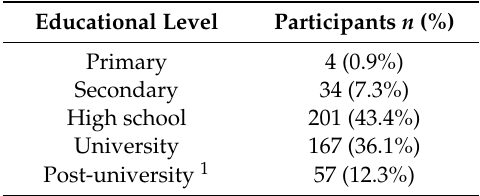
Table 2. Frequencies of the educational level of the